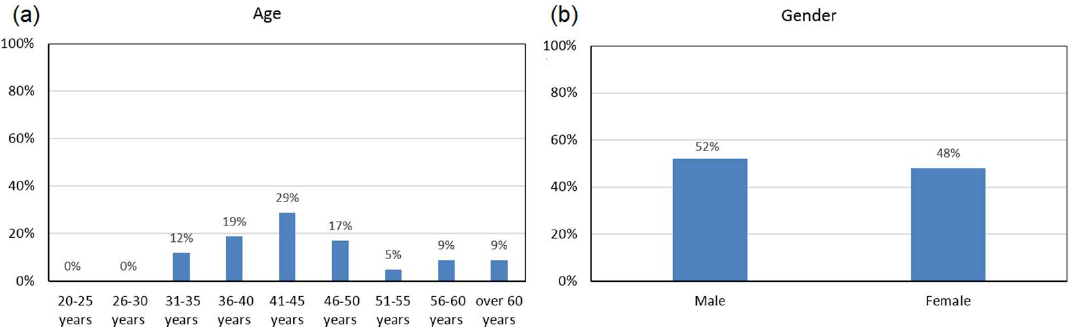
Figure 5. Results of willingness-to-pay questions.